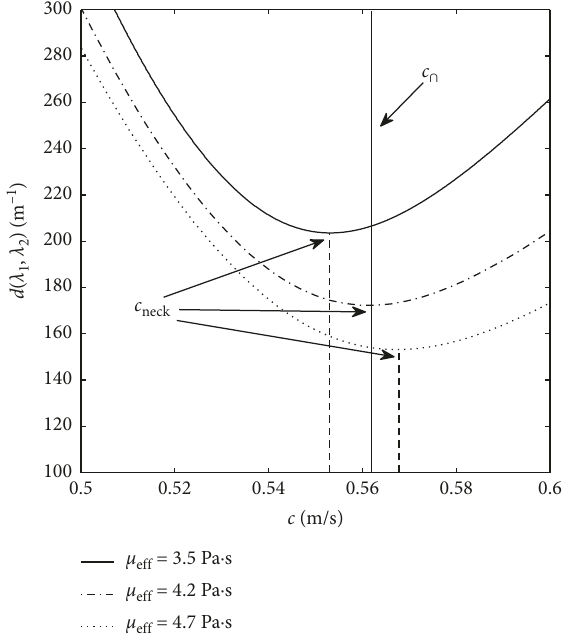
Figure 7: Criterion for choosing the effective viscosity (same system as in Figure